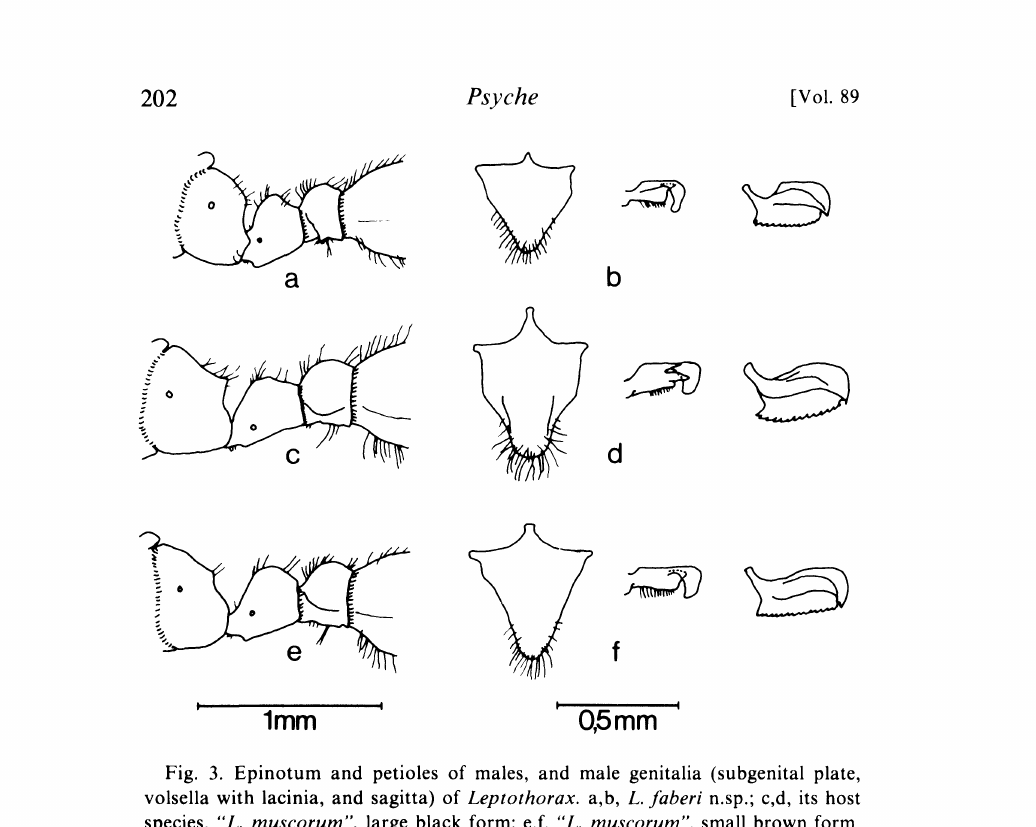
Fig. 3. Epinotum and petioles of males, and male genitalia (subgenital plate, volsella with lacinia, and sagitta) of Leptothorax. a,b, L. faberi n.sp.; c,d, its host species, "L. muscorum", large black form; e,f, "L. muscorum", small brown form. The shapes of the sagitta and volsella with lacinia vary considerably in all 3